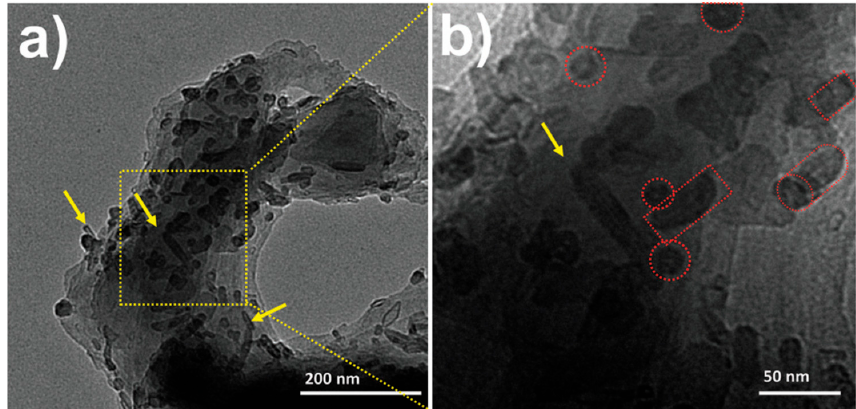
Figure 8. TEM micrograph of polythiophene (PTh)- g -(poly(ethylene glycol) (PEG)- r -biopolymer polycaprolactone (PCL) at ( a ) low magnification and ( b ) high magnifications. Porous spherical particles were highlighted with red circles while, rod-like structures are marked with rectangular forms and yellow arrows. Reprinted with permission from reference [96]. Copyright © The Royal Society of Chemistry 2019.